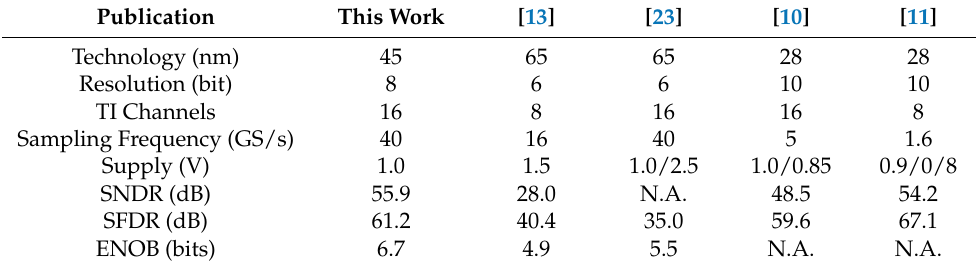
Table 1. Comparison of the proposed method with some state-of-the-art TI-ADCs.